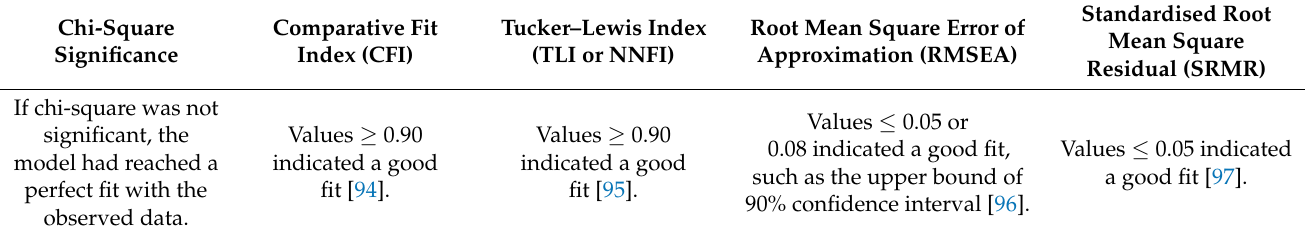
Table 1. Fit indices suggested for the